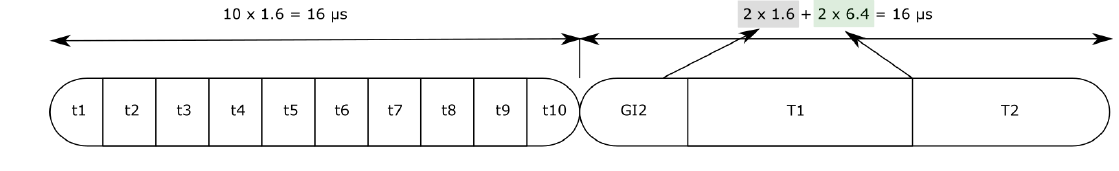
Figure 4. IEEE 802.11p packet preamble